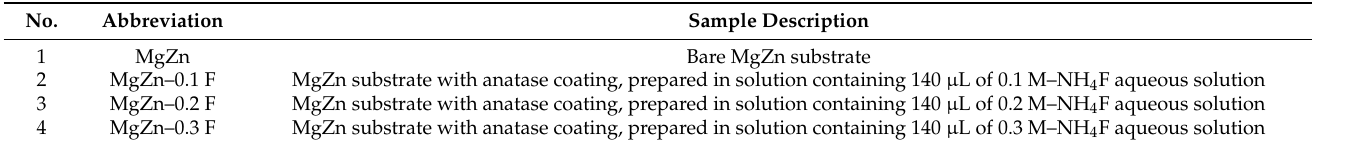
Table 1. List of the abbreviations used in this